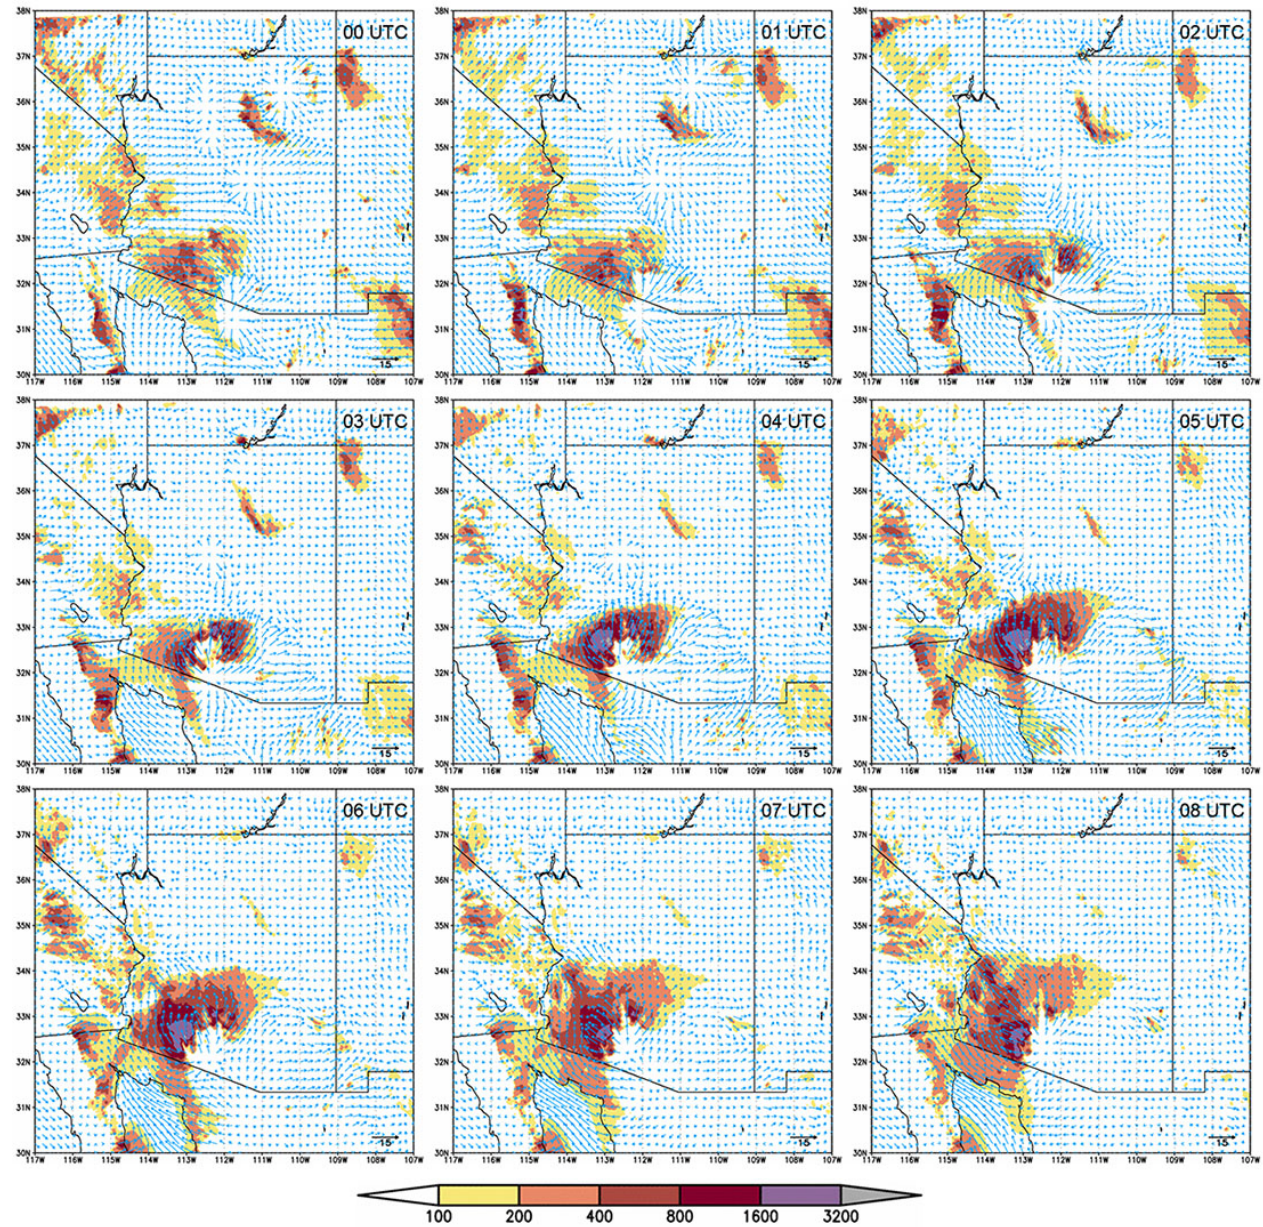
Fig. 2. NMME–DREAM PM 10 surface dust concentration (µgm − 3 ) and wind on 10m height (ms − 1 ), on every hour for the period 00:00– 08:00UTC 6 July